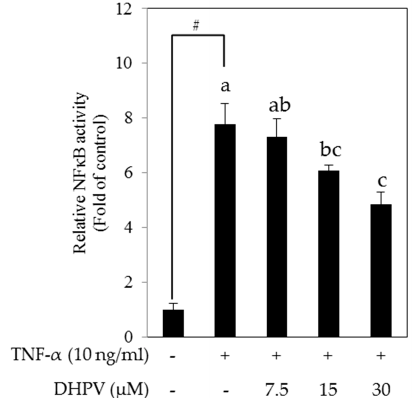
Figure 5. Effect of DHPV on TNF- α -induced NF- κ B transcriptional activity. Following pretreatment with DHPV and TNF- α -stimulation, NF- κ B transcriptional activity was measured in HUVECs transfected with NF- κ B luciferase reporter plasmids. Data are expressed as means ± SD ( n = 4). # p < 0.05 versus control. Different letters denote significant differences ( p < 0.05); values bearing the same letters are not significantly different from each other.